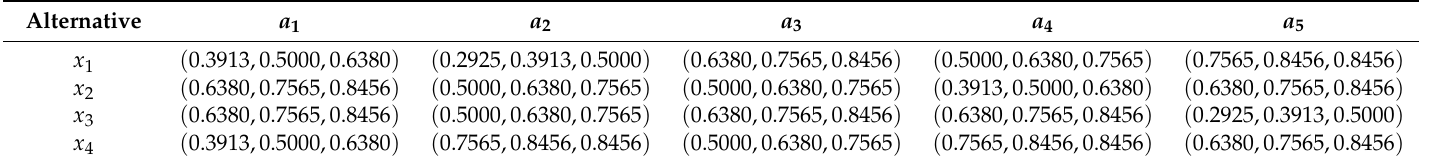
Table 6. Triangular fuzzy decision matrix (cid:101) D 3 =